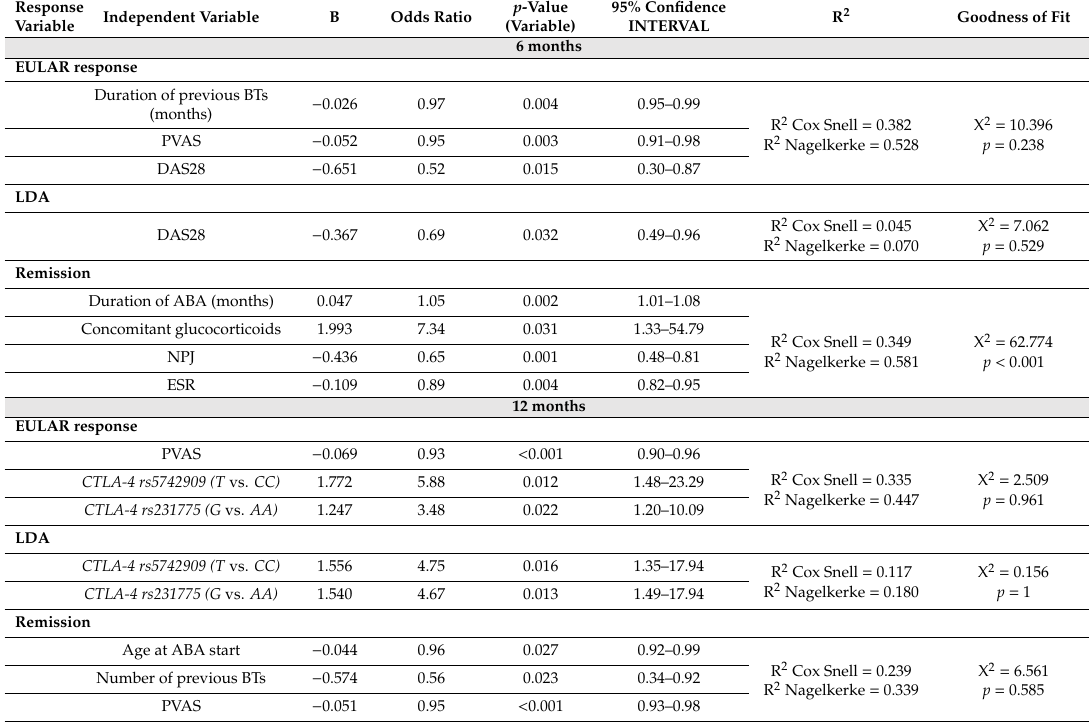
Table 3. Predictors of response at 6 and 12 months of treatment with abatacept in rheumatoid arthritis patients (multivariate